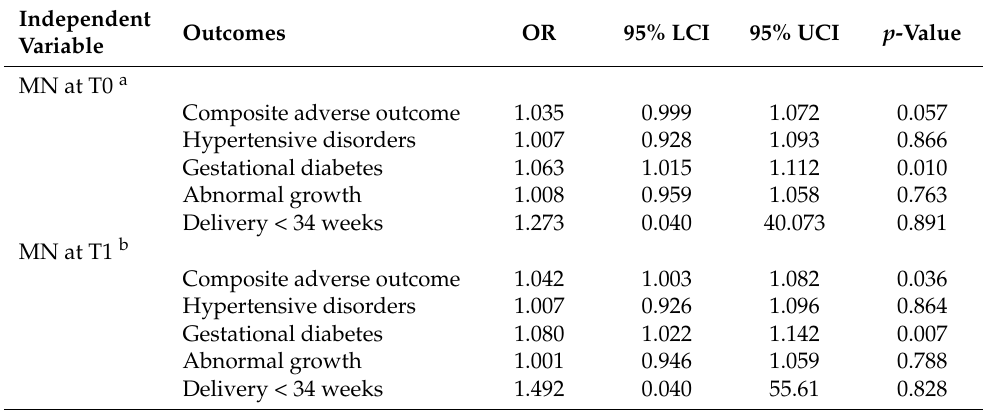
Table 6. Association of adverse outcomes with MN titer measured the first trimester of pregnancy (T0) and peripartum (T1).